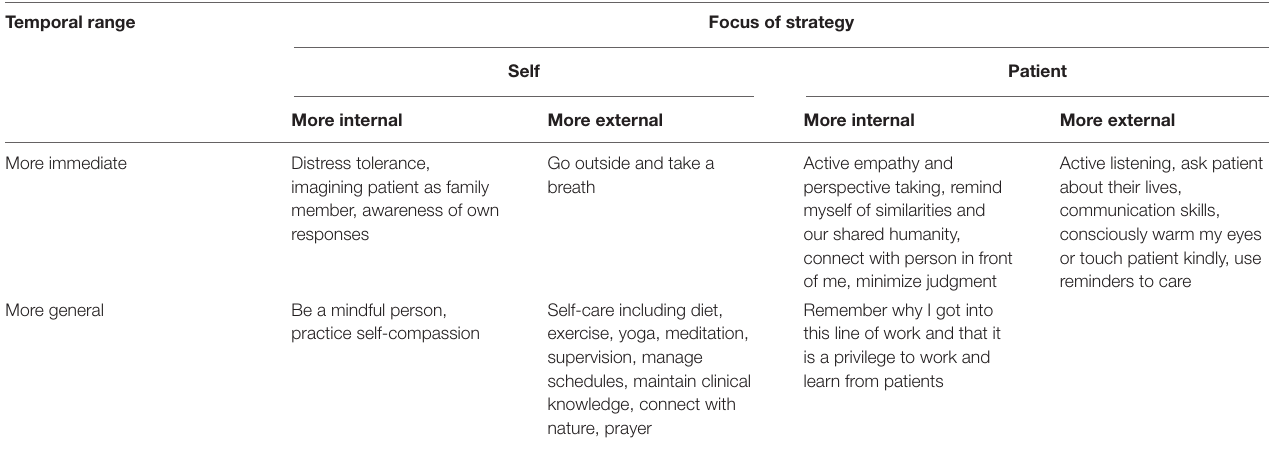
TABLE 4 | Preliminary typology of self-reported strategies to maintain compassion (with examples). Temporal